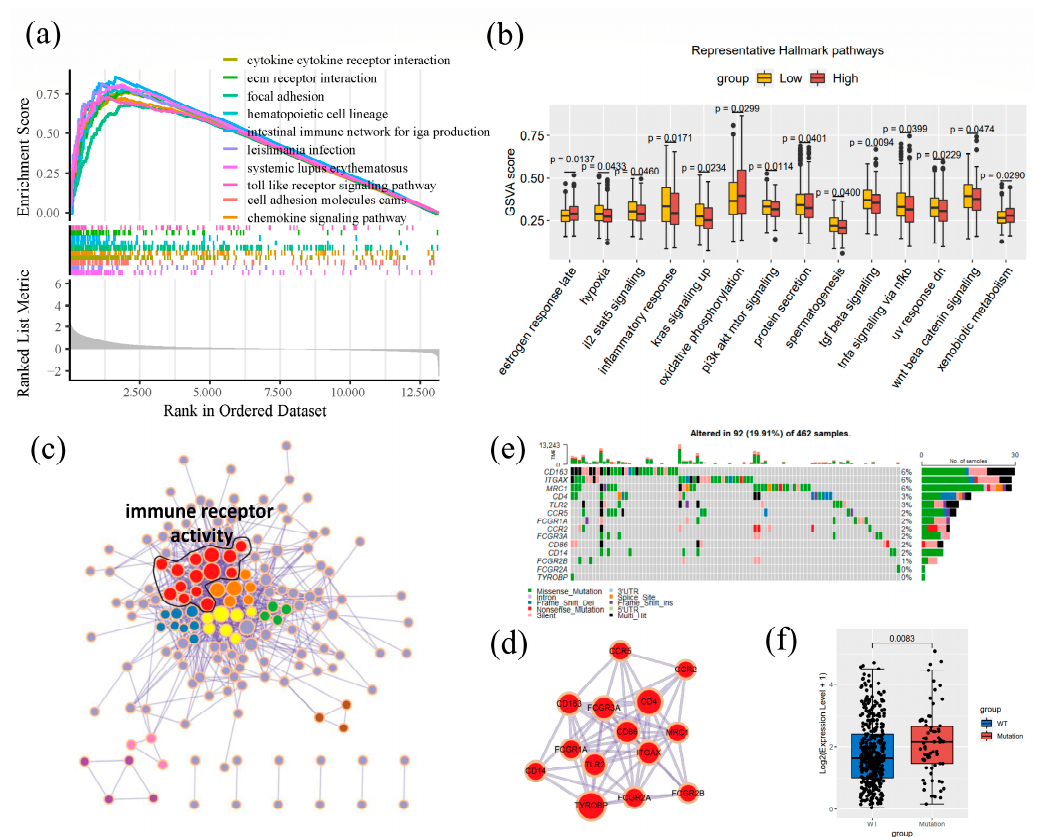
Figure 6. Analysis of potential biological processes associated with CD163. ( a ) Top 10 pathways based on GSEA enrichment results of CD163. ( b ) Difference between CD163 high and low expres- sion groups in several hallmark pathways. ( c ) Gene enrichment results in protein–protein interac- tion (PPI) network of colorectal cancer. ( d ) Modules involving CD163 in PPT network. ( e ) Mutations of all genes from CD163 module in PPI network. ( f ) The relationship between CD163 expression and mutation of CD163 module in PPI network. 4. Discussion In this study, we analyzed the expressions of CD163 and other genes in CRC and evaluated their relationships to clinical outcomes in CRC patients. After analyzing data from public databases using gene expressional difference analysis, we found that CD163 expression in CRC was lower compared to normal tissue. Up-regulated CD163 expression seemed to be a negative prognostic factor for CRC based on the Cox analysis, which was also confirmed by survival analysis based on clinical CD163 expression data. Enrichment analysis and protein–protein interactions networks showed that CD163 was related to several molecular functions and hallmark pathways. Thus, based on these findings, we propose that CD163 could be regarded as a biomarker for tumor progression and clinical outcomes in CRC, where a low expression may be seen in the early stages of development, and high expression may suggest invasion, metastasis, and a low survival rate. In accord- ance with this study, our previous studies on CD163 have also shown positive expression